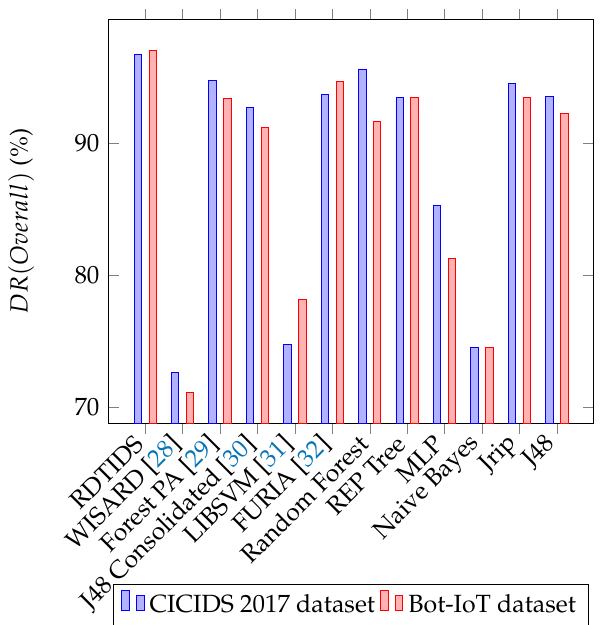
Figure 5. Overall Performance of RDTIDS and other classifiers in terms of accuracy.